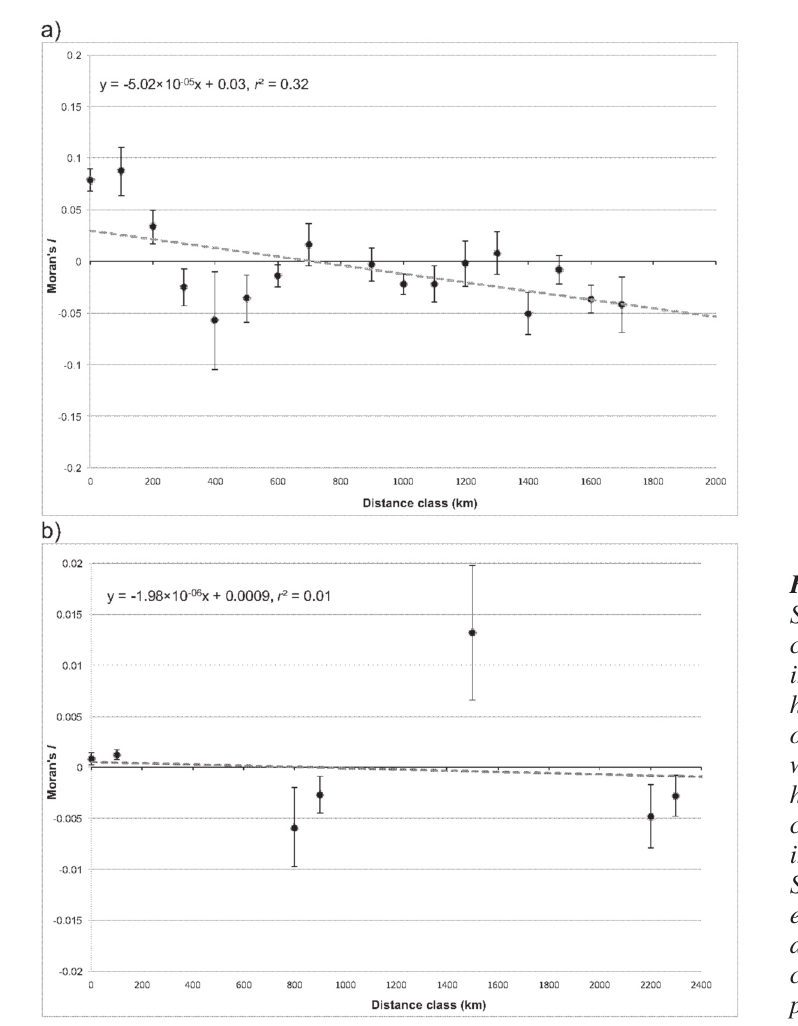
Fig. 4. Spatial auto- correlation among individuals sampled at haul-out sites, based on Moran’s I, for walruses in the a) high Arctic, and b) central Arctic clusters inferred from STRUCTURE. The equation for the line and correlation coefficient are